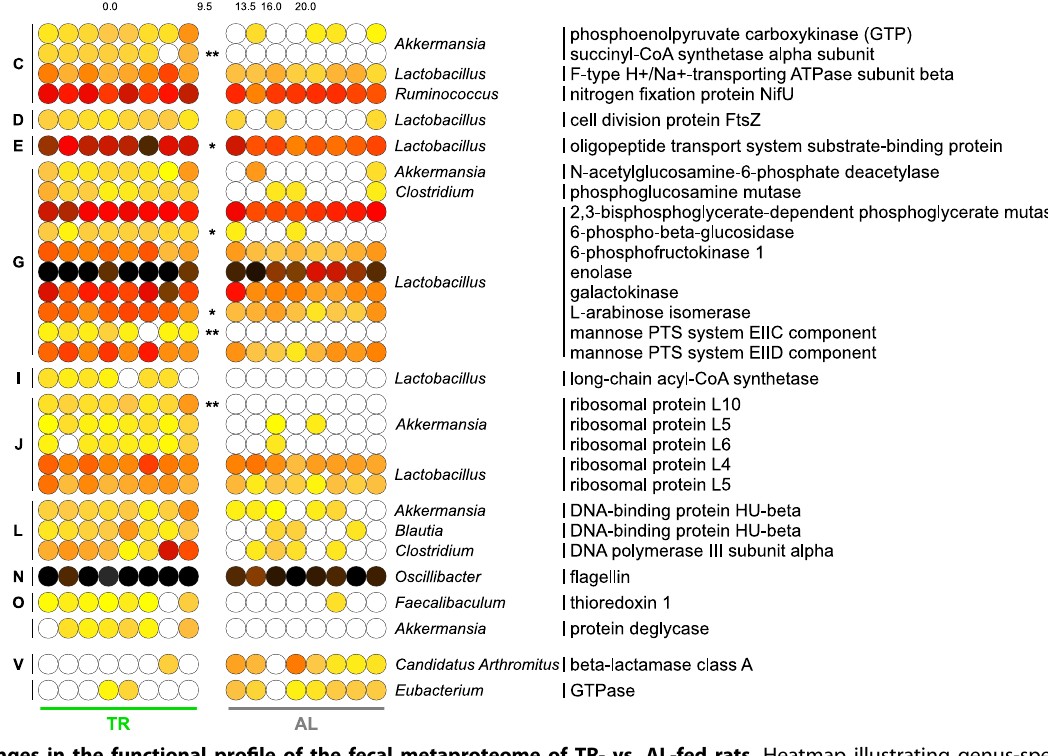
Fig. 4 Changes in the functional pro fi le of the fecal metaproteome of TR- vs. AL-fed rats. Heatmap illustrating genus-speci fi c functions with signi fi cantly differential abundance between AL and TR groups (FDR < 0.1). A single or double asterisk refers to FDR < 0.01 or <0.001, respectively. Each dot indicates a different sample; the color gradient is based on the relative abundance of functions. Functions are ordered sequentially: (i) according to the group of rats in which they are signi fi cantly more abundant, indicated in the bottom; (ii) according to their COG category, indicated close to the left margin of the heatmap (C, Energy production and conversion; D, Cell cycle control, cell division, chromosome partitioning; E, Amino acid transport and metabolism; G, Carbohydrate transport and metabolism; I, Lipid transport and metabolism; J, Translation, ribosomal structure and biogenesis; L, Replication, recombination and repair; N, Cell motility; O, Posttranslational modi fi cation, protein turnover, chaperones; V, Defense mechanisms); (iii) according to the taxonomic genus to which they were assigned, indicated close to the right margin of the heatmap; (iv) in alphabetical order.